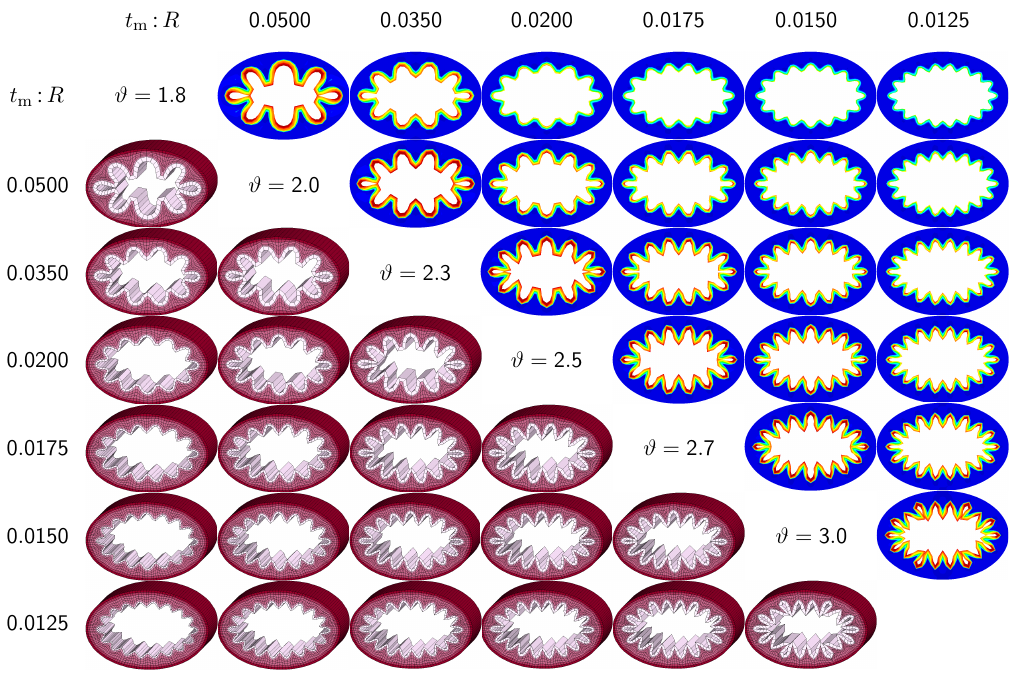
Figure 7. Sensitivity of the failure mode with respect to relative mucosal thickness for : R = 1 . 5 . The instability occurs naturally moderately elliptical cross-section with R I II at regions of highest curvature along the semi-major axis and propagates inward until it reaches the semi-minor axis. First contact occurs at regions of highest curvature and induces a moderately localized failure mode. This might indicate that airway obstruction is less drastic in moderately elliptical cross-sections than in circular cross-sections.